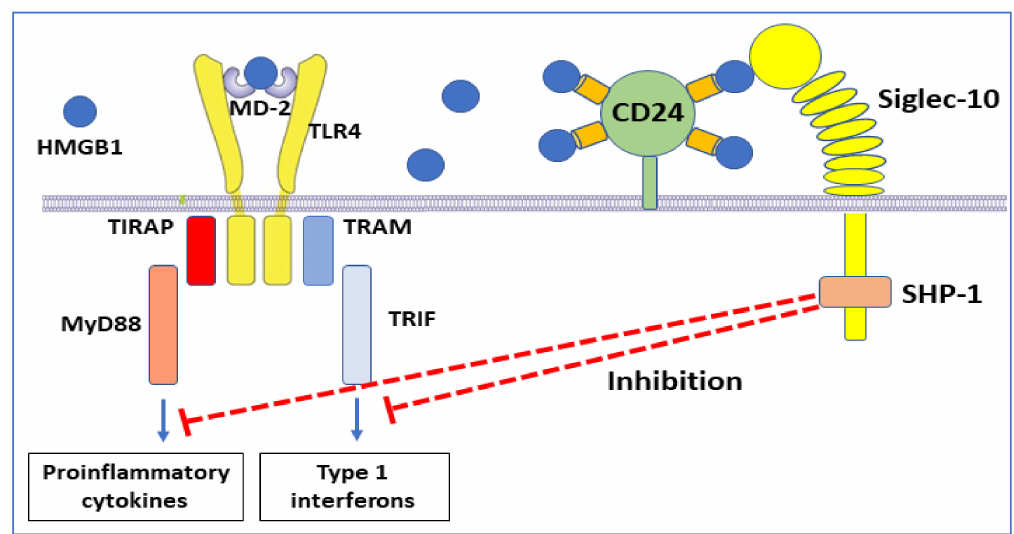
Figure 6. An anti-inflammatory HMGB1-dependent pathway. A trimolecular complex formed by HMGB1, CD24, and Siglec-10 generates intracellular cell signaling that turns off NF- κ B-dependent inflammatory processes.